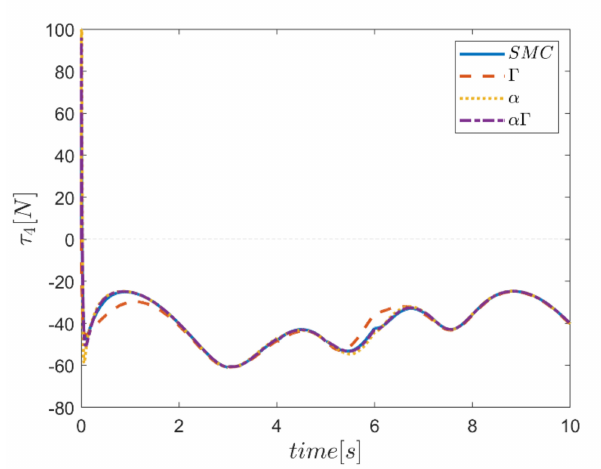
Figure 31. Comparison of input force in the fourth actuator.